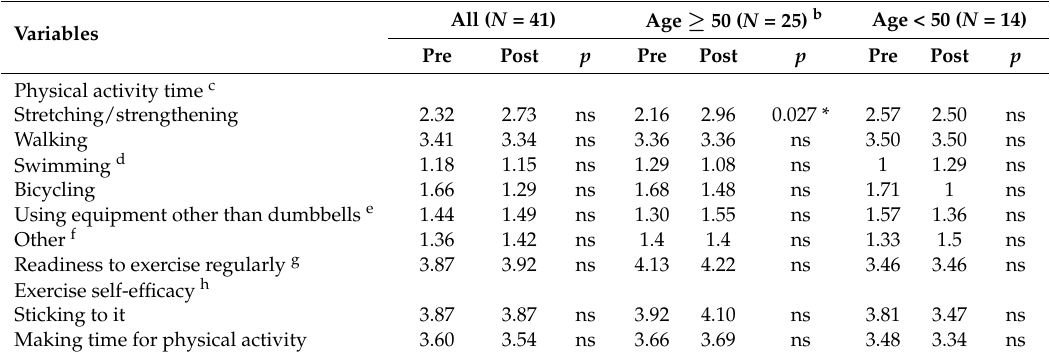
Table 2. Home care aides’ physical activity: Before and after 4-month intervention a ( N =